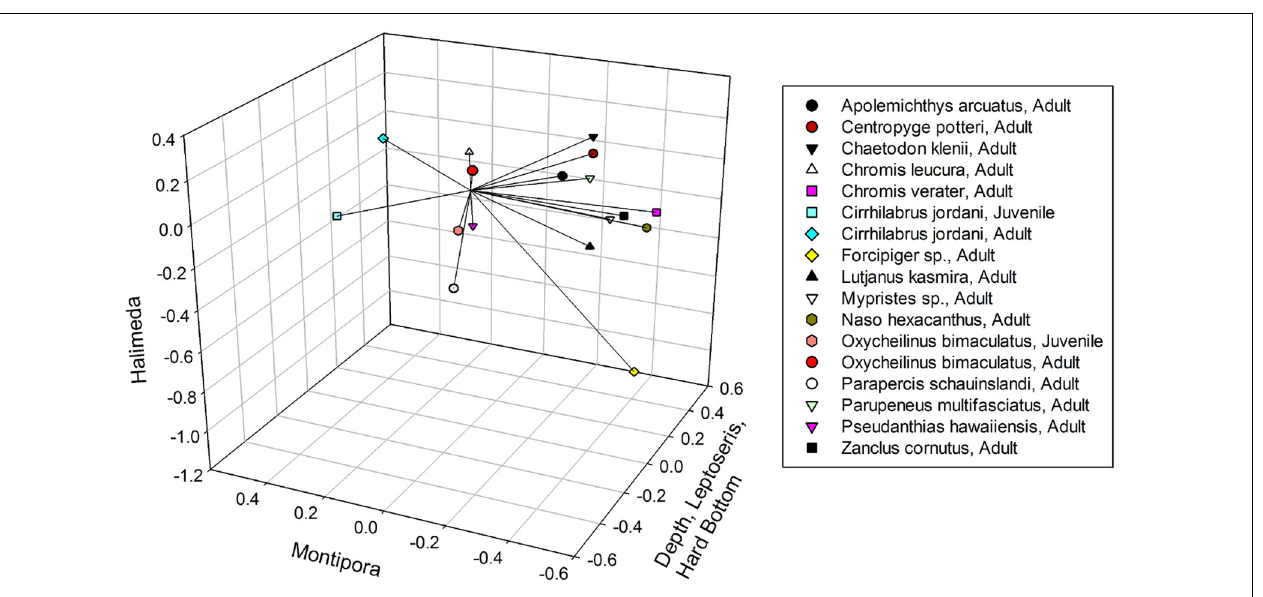
in the transition zone. Three singular surveys had unusual fish abundance that impacted their compatibility with other